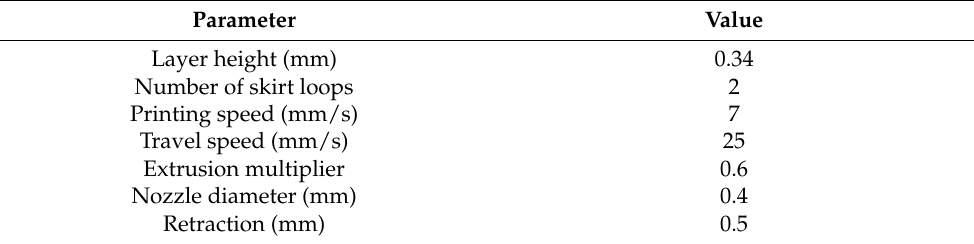
Table 1. Experimental parameters of 3D printing.